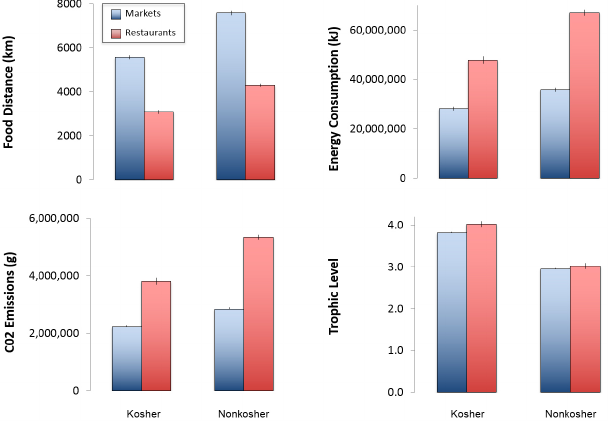
Fig. 1 . Estimated average food distance, energy consumption, carbon dioxide emissions, and trophic level of 4492 kosher and nonkosher seafood items sampled from markets and restaurants in Southern California. Food distances were measured as orthodromic distances from the geographic midpoint of a particular region or from a county's or region's largest major harbor to Ventura, California. Energy consumption and carbon dioxide emissions are based on food distance as well as information from seafood venders regarding transportation modes, e.g., air, rail, or ship. Our estimates